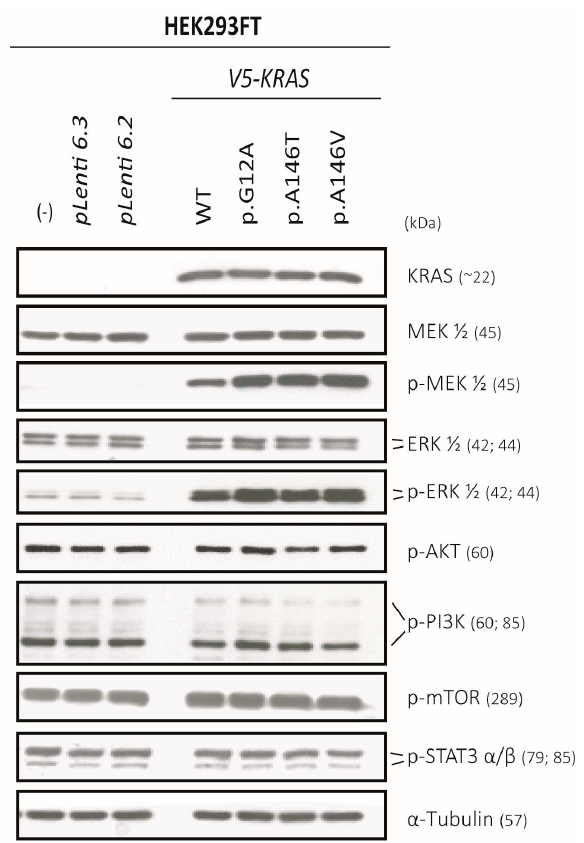
Figure 4. Representative expression and activation-levels of RTK effectors after transfection of KRAS WT and KRAS mut constructs into HEK293 cells. The corresponding original Western blots are shown in Figure S3. The raw intensities and the intensity ratios for each band are listed in Table S3.